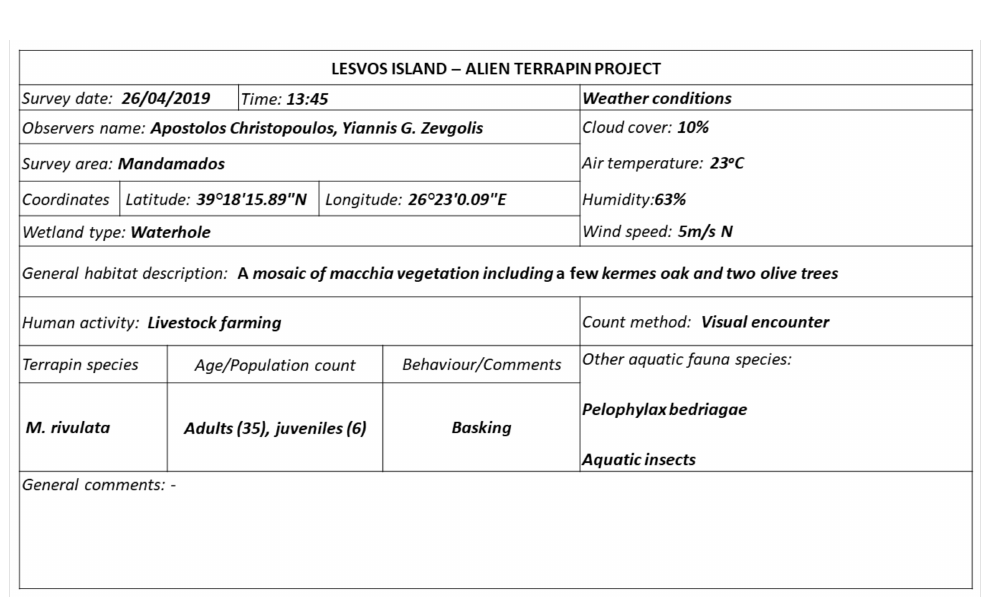
Figure A1. An example of an inventory form that was used in the field